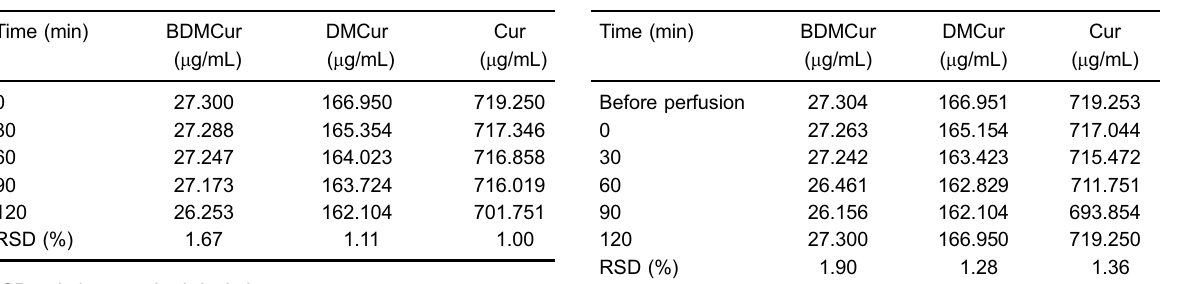
Table 7. Results of the absorption test through the perfusion tube of bisdemethoxycurcumin (BDMCur), demethoxycurcumin (DMCur) and curcumin